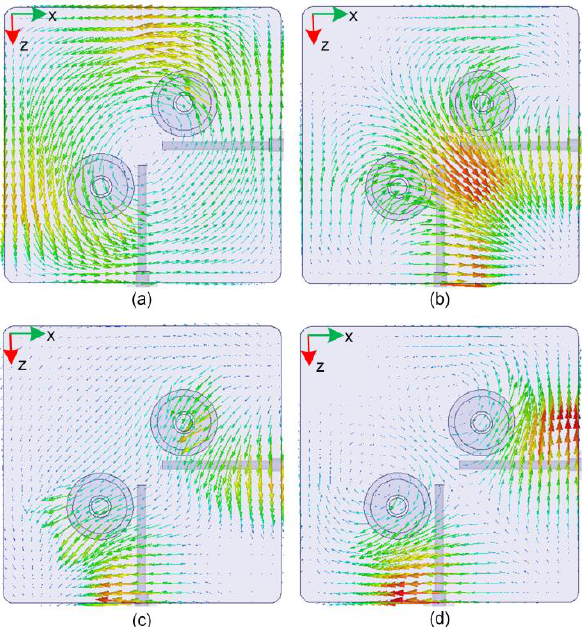
Figure 2. Field distributions of the five resonant modes: ( a ) magnetic field distribution of quasi-TM 01 mode; ( b ) magnetic field distribution of quasi-TM 11 mode; ( c ) magnetic field distribution of quasi-TM mode-3; ( d ) magnetic field distribution of quasi-TM mode-4.